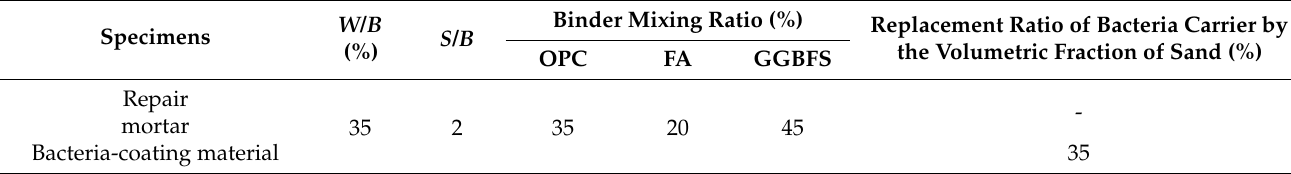
Table 2. Mixing proportions of repair mortar and bacteria-coating material.